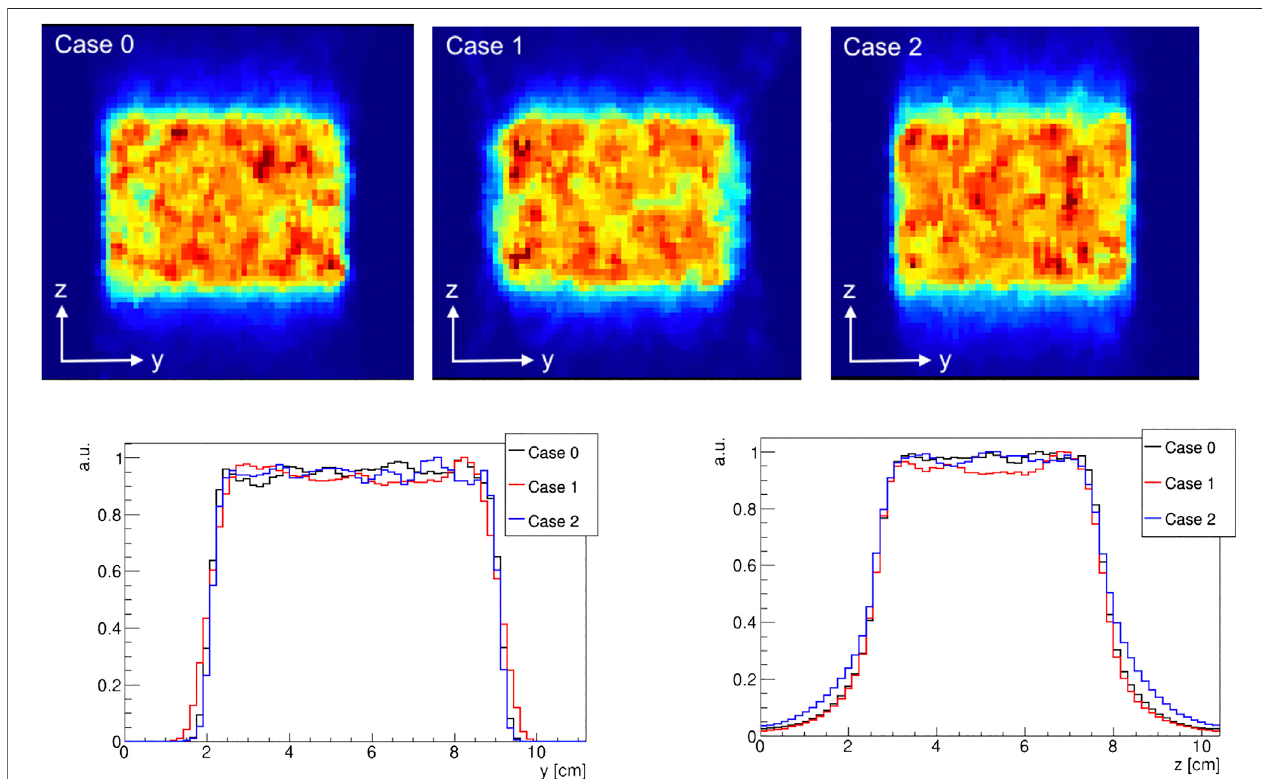
FIGURE 5 | central slice in the (y, z) plane of a reconstructed homogeneous activity distribution for case 0, case 1, and case 2 (top) . The corresponding activity pro fi les along the y and z directions, evaluated at the central slice (bottom) .